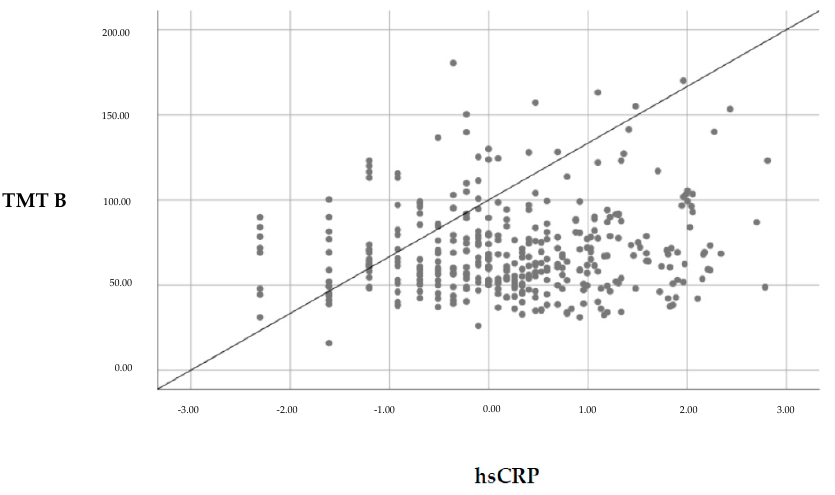
Figure 1. Association of serum high-sensitive C-reactive protein (hsCRP) concentration and Trail-Making Test B